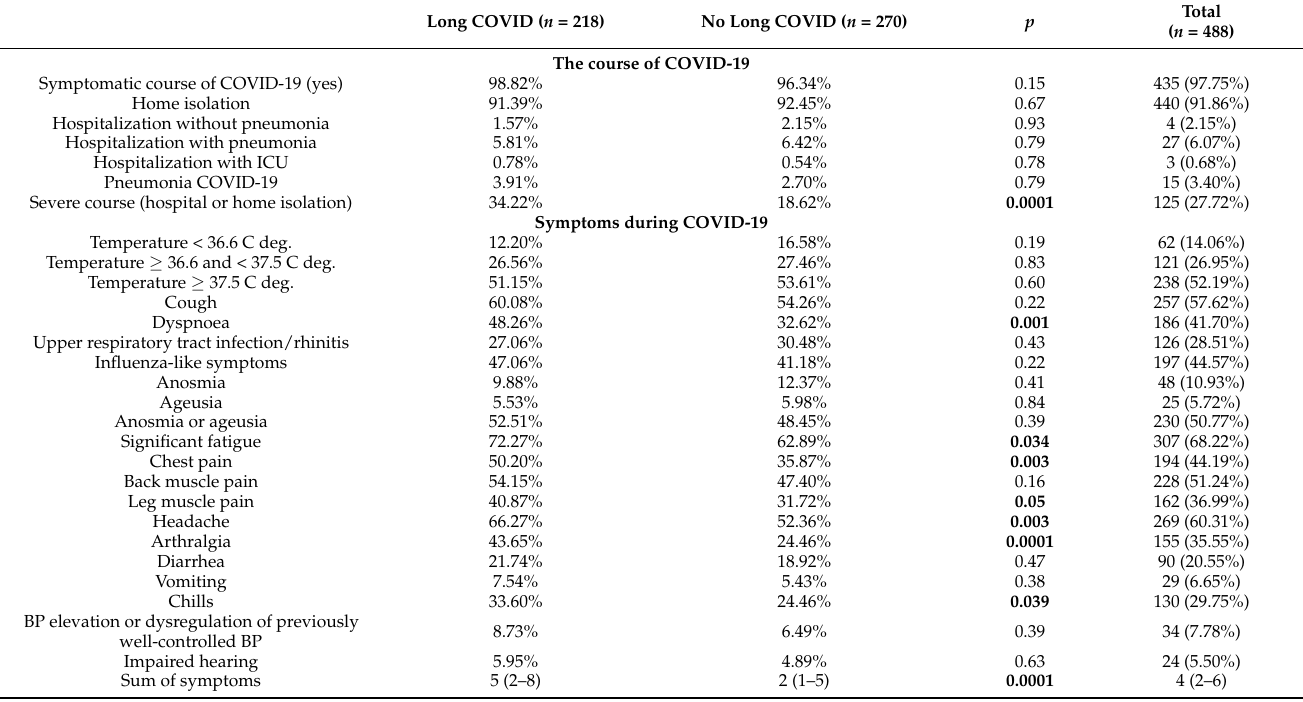
Table 2. The assessment of the course and COVID-19 symptoms in both